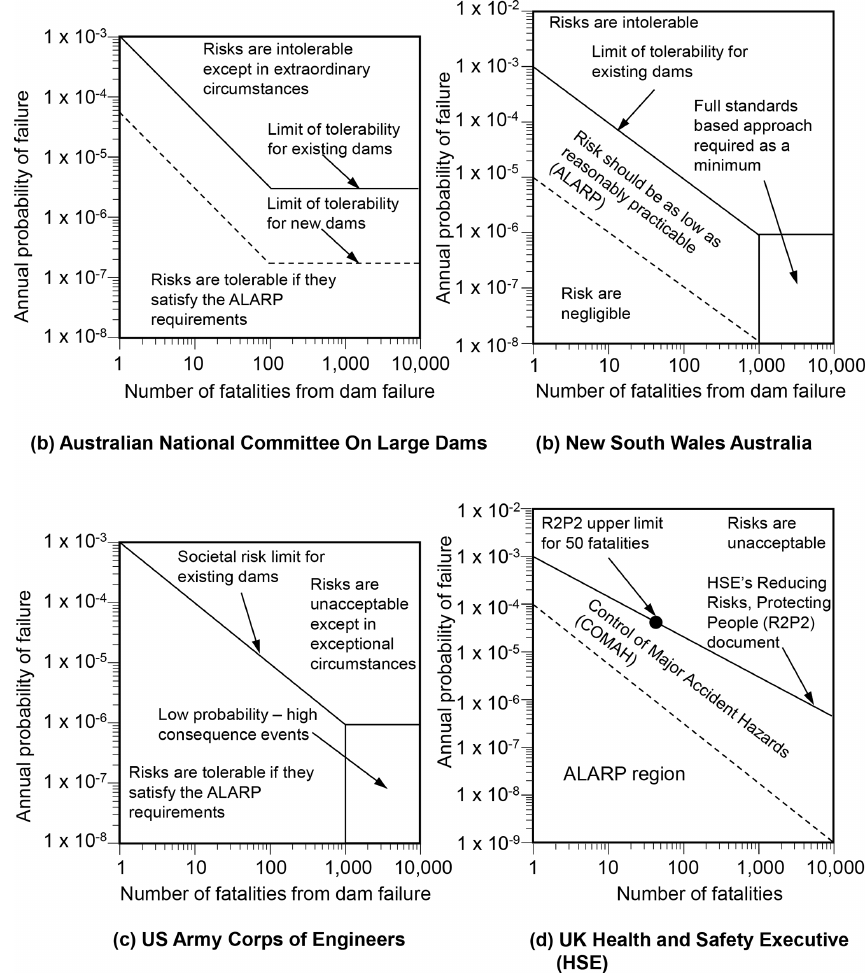
Figure 12. Graphs showing the acceptable risk in terms of the annual probability of failure and loss of life for dams in Australia and the USA and major hazards in the UK (sources: ANCOLD, 2003; HSE, 2001; NSW Department of Planning, 2011; USACE,